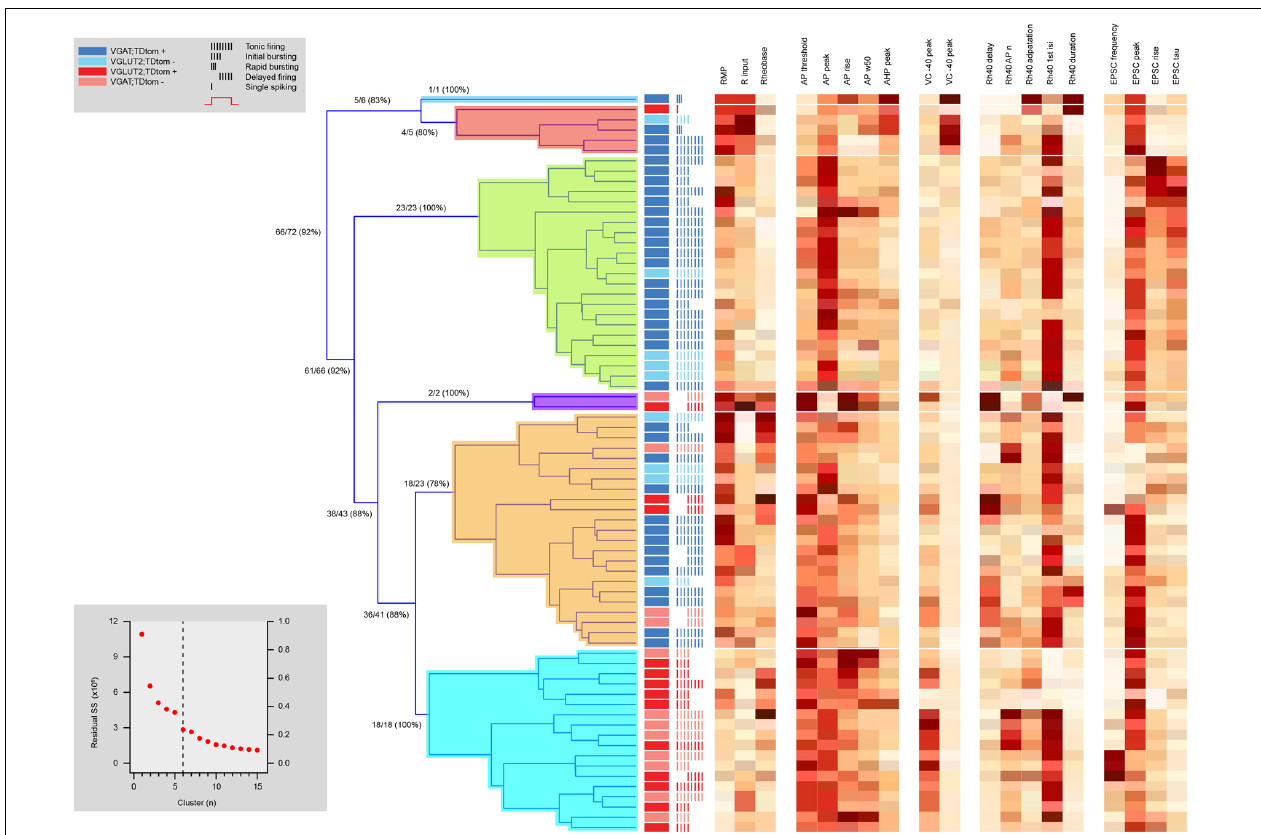
FIGURE 6 | Hierarchical cluster analysis of excitatory and inhibitory dorsal horn neurons on electrophysiological attributes. Dendrogram and heatmaps plotting the assignment of dorsal horn neurons into clusters based on their electrophysiological properties. The distribution of excitatory and inhibitory neurons and their AP discharge responses are annotated using the key summarized in the upper left gray box, denoting neuron type and discharge pattern (inset). Dendrograms show the clusters (six for this analysis) determined using a K-Means elbow method, which plots the sum of squares error (SSE) for increasing cluster number to determine the point where adding another cluster does not appreciably improve the SSE (lower gray box inset). Clusters included one large inhibitory population (green cluster in dendrogram), one large excitatory population (blue), and one large mixed population of cells (orange), as well as three smaller clusters (deep blue, red, and purple). Heat maps highlight the relationship of 19 electrophysiological characteristics to each cell cluster